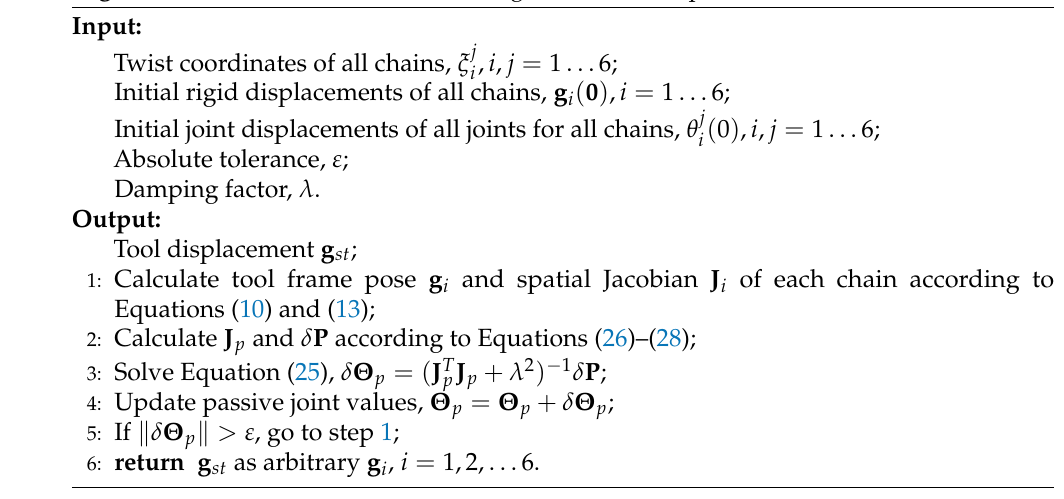
Algorithm 1 Forward kinematics of the general Stewart